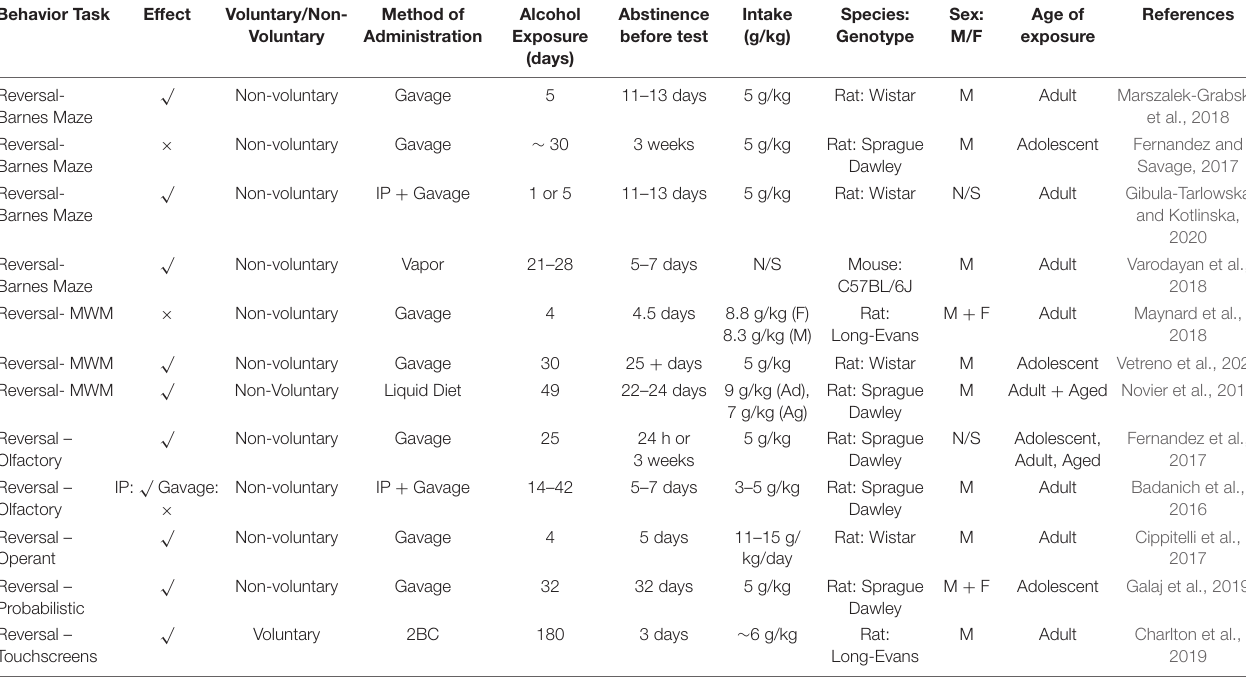
TABLE 3 | Reversal learning summary from reviewed studies outlining behavior task, effect, methodology and subjects. Behavior Task